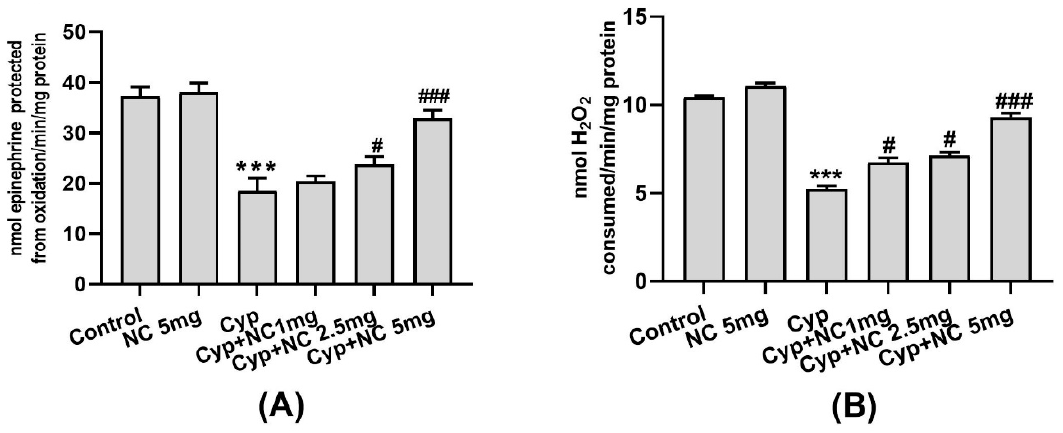
Figure 2. Cur-NLC treatment boost activities of SOD ( A ) and catalase ( B ). Data presented as mean ± SEM (n = 6). *** p < 0.001 vs. control, # p < 0.05, ### p < 0.001 vs. Cyp group. Cyp = Cypermethrin; NC = NLC.